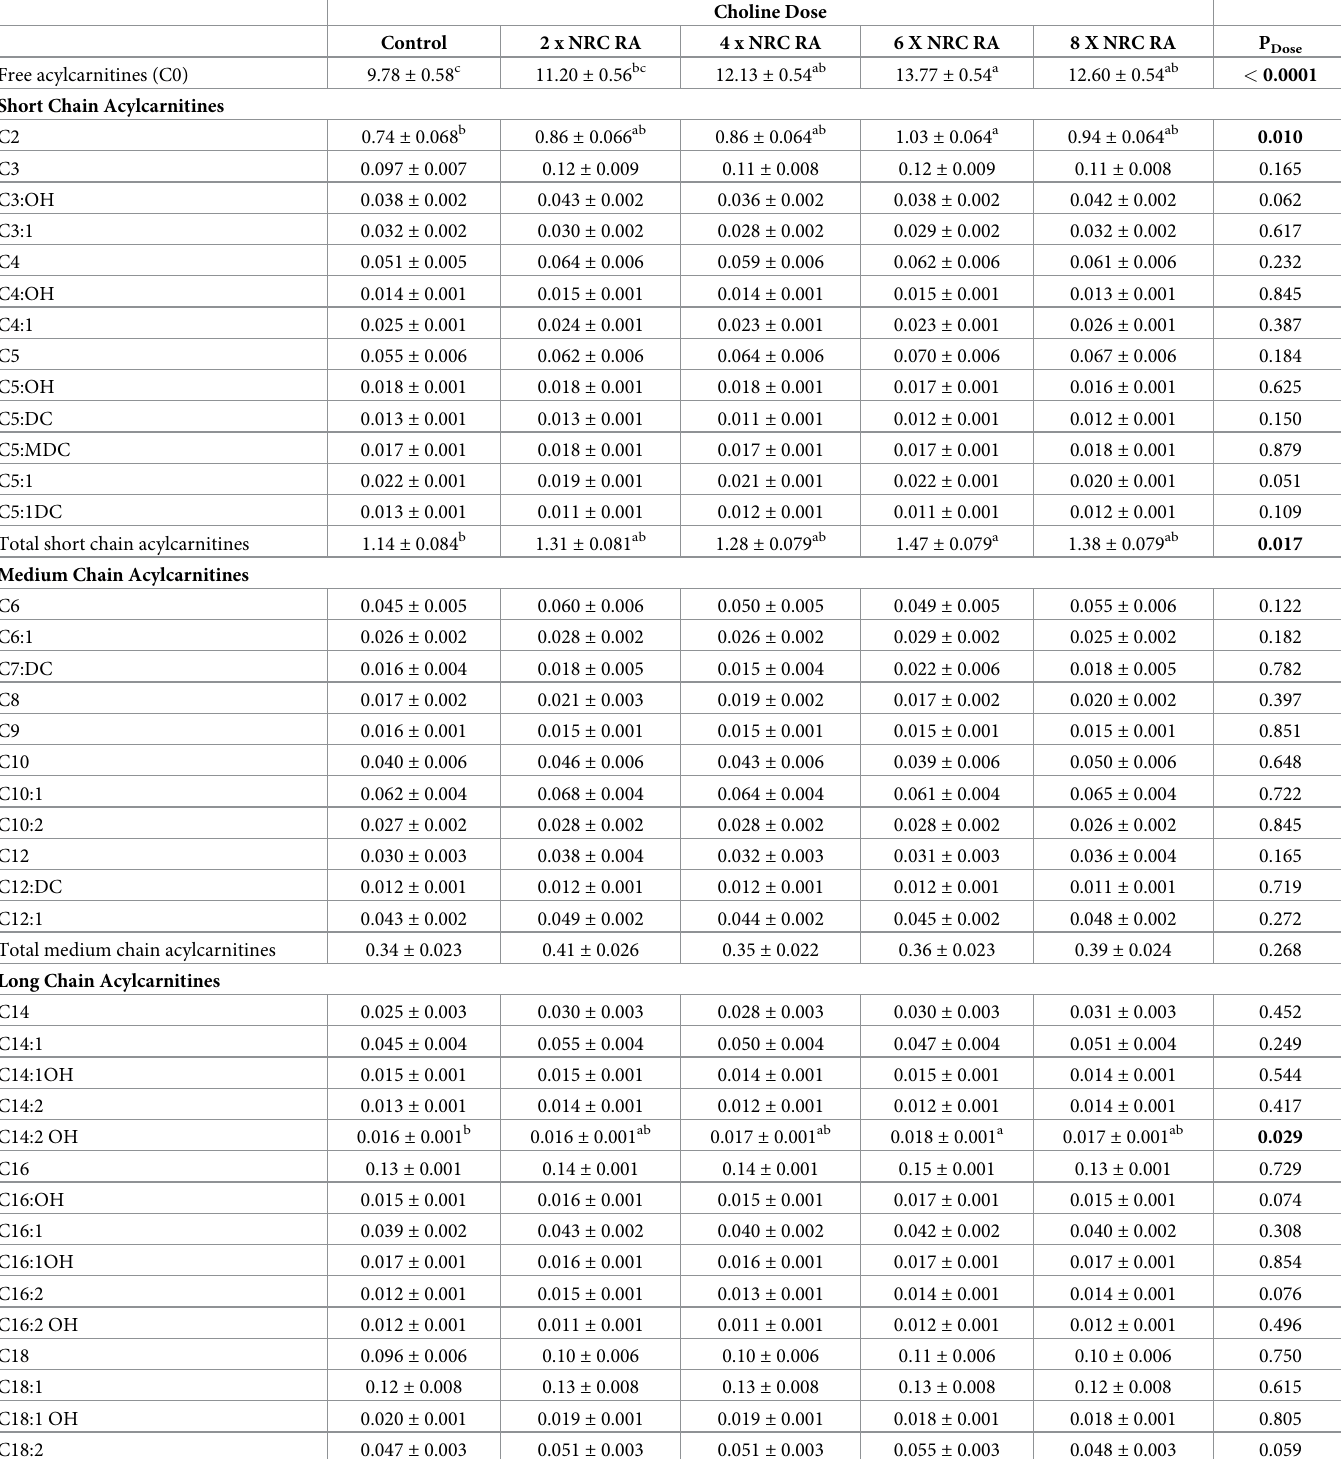
Table 4. Mean serum concentrations ( μ M) of acylcarnitines determined by DI-MS in overweight cats (n = 14) receiving control (no additional choline supplementa- tion, 1.2 x NRC RA, 77 mg/kg BW 0.67 ), choline at 2 x NRC RA (126 mg/kg BW 0.67 ), 4 x NRC RA (252 mg/kg BW 0.67 ), 6 x NRC RA (378 mg/kg BW 0.67 ), and 8 x NRC RA (504 mg/kg BW 0.67 ), in a 5 x 5 Latin square design for 3-week